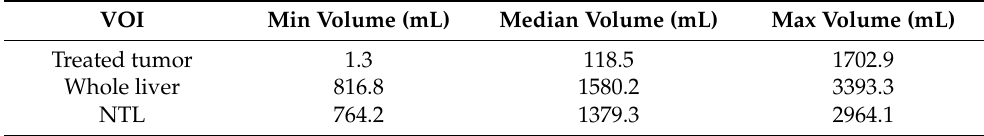
Table 1. Volumes of treated tumor and whole liver in mL. VOI Min Volume (mL) Median Volume (mL) Max Volume (mL) Treated